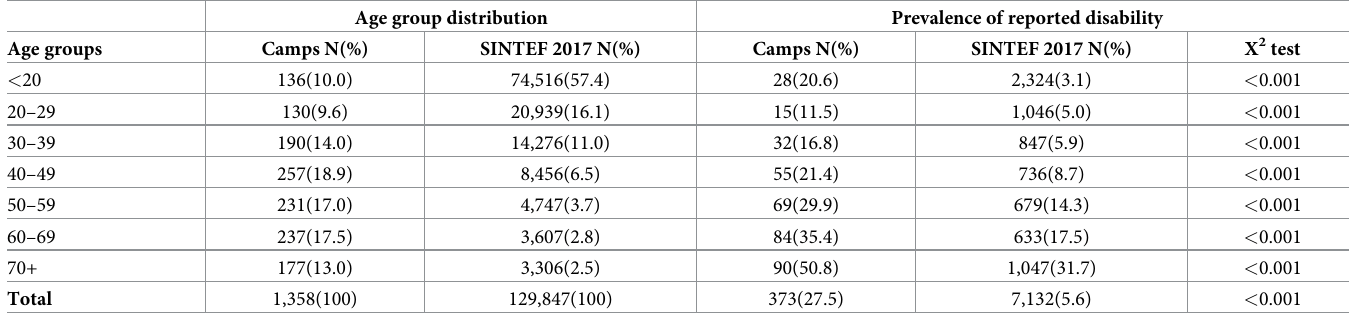
Table 5. Comparison of sample prevalence of reported disability and SINTEF disability national survey